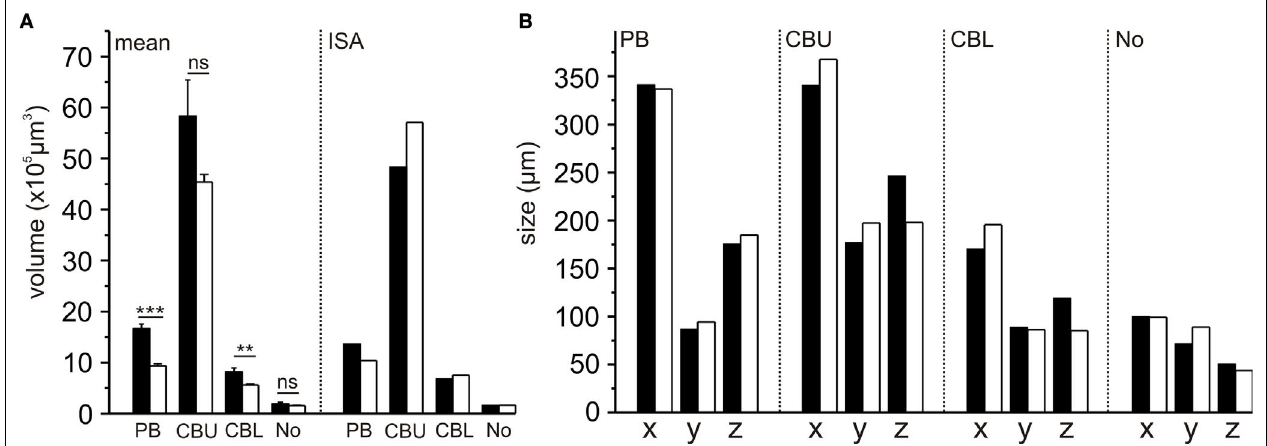
FIGURE 4 | Comparison of volumes and sizes of central-complex subdivisions between the 10-animal standard whole brain ( black bars ; from Kurylas et al., 2008) and the 20-animal standard central complex ( white bars , this work). (A) Comparison of the means and ISA neuropil volumes (bars: